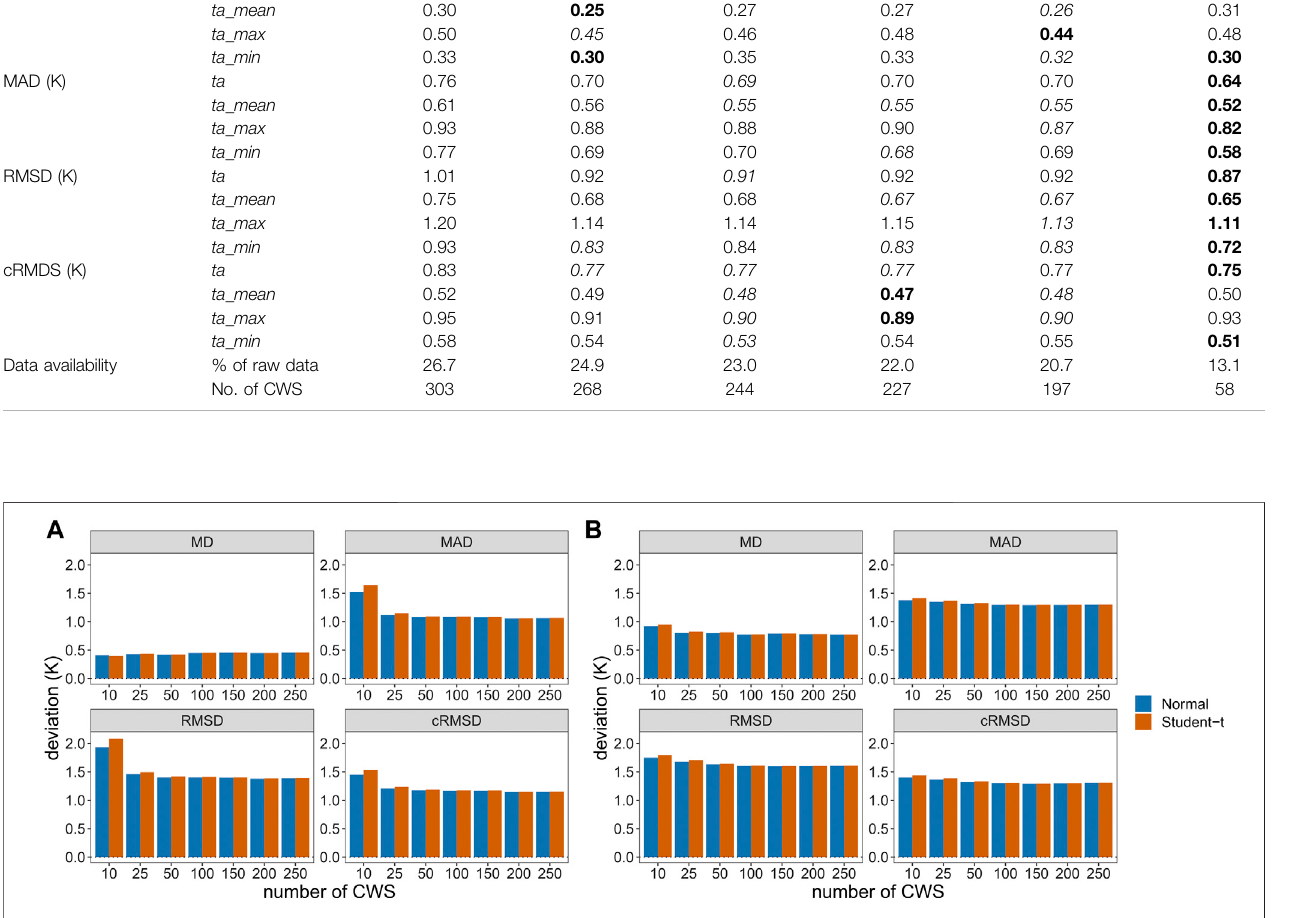
FIGURE 5| Mean annual deviations in hourly air temperature ( ta ) between CWS and PRWS in (A) Amsterdam during 2019 and (B) Toulouse during 2020after QC levelm2forsubsamplesoftheCWSdataset.SubsampleswererandomlyselectedafterQClevelm1inabootstrapexperiment( n (cid:1) 100).Deviationswerecalculatedper bootstraprunbetweeneachPRWSandeachCWSwithinaradiusof2000 maroundtherespectivePRWS,locatedinthesameLCZtypeasthePRWS.Deviationswere then averaged across all CWS and PRWS, the whole investigation period of each city (cf. Table 1 ) and all bootstraps. MD, mean deviation; MAD, mean absolute deviation; RMSD, root-mean-square deviation; cRMSD, centred